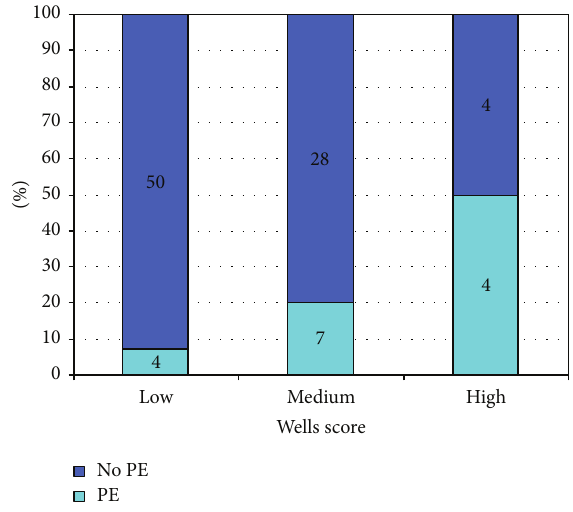
Figure 4: Stratification of patients via Wells score and PE